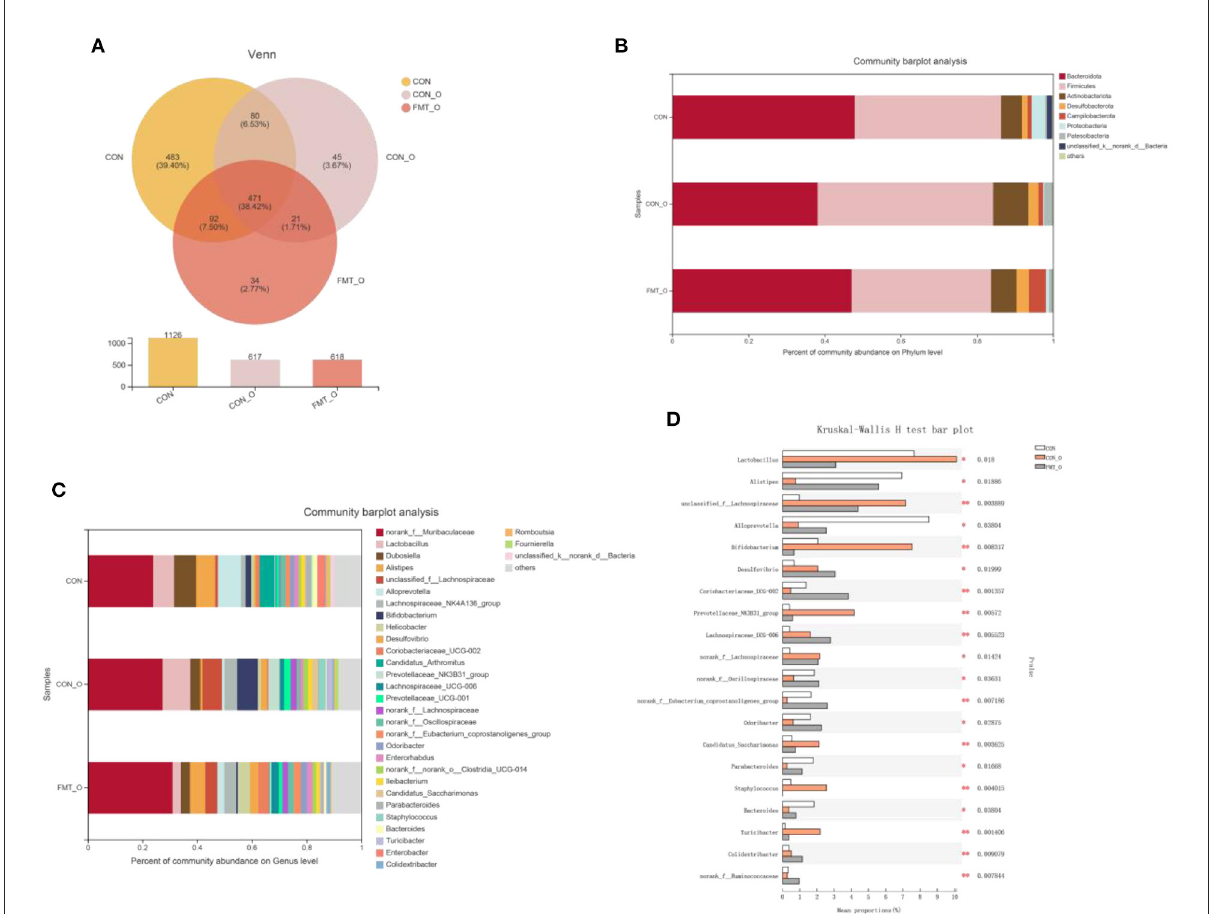
FIGURE6 Significant change of gut microbial composition was found in older mice, which was screened by fecal microbiota transplantation ( n = 6). The down-regulated OTU number is shown in here (A) . Phylum-level abundance as a percentage of total community abundance (B) . The top 30 in community abundance in terms of genera percent (C) . The significantly different genera (D) . Kruskal-Wallis test with Dunn post hoc test was used for statistical tests. * p < 0.05, ** p < 0.01, *** p <